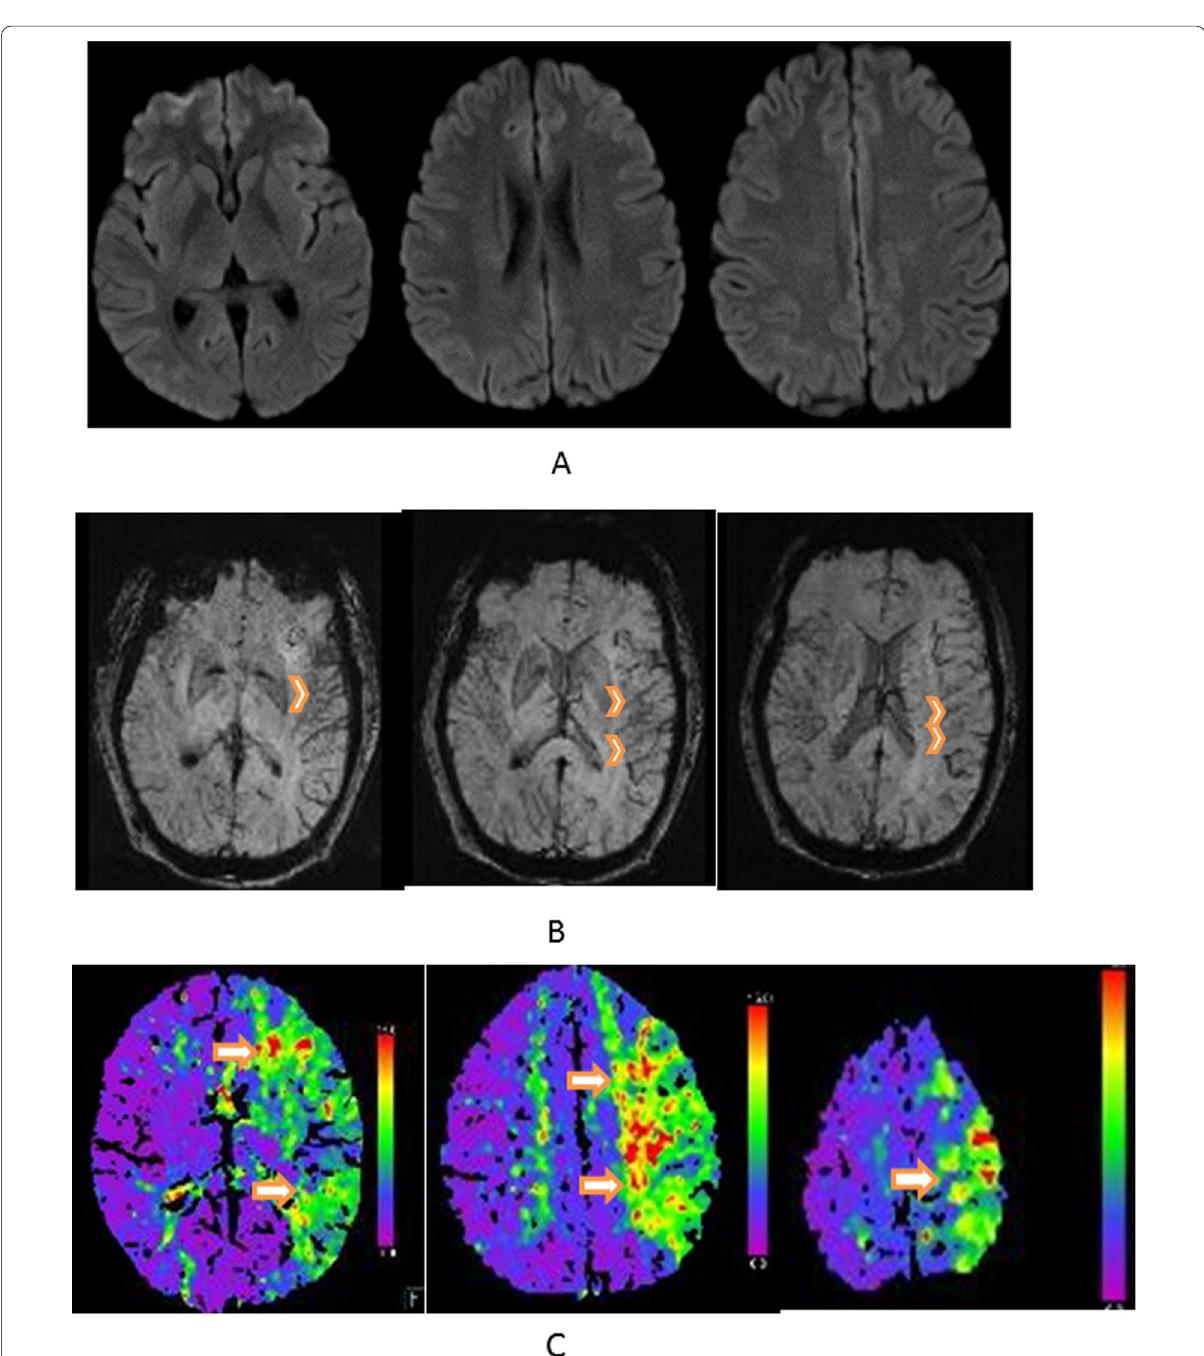
Fig. 3 a DWI shows no definite abnormality along the territory of MCA at both sides. b SWI of the same patient revealed asymmetrical vessel sign in the form prominent cortical veins (arrow head) on the left cerebral hemisphere along (M1‑M6 segments) representing the area at risk with ASPECT score 4. c CT perfusion of the same patient revealed asymmetry in tissue perfusion between the left and right hemisphere with affected left cerebral hemisphere along (M1‑M6 segments) (white arrow) as well as left lentiform nucleus (black arrow) representing the area at risk with aspect score